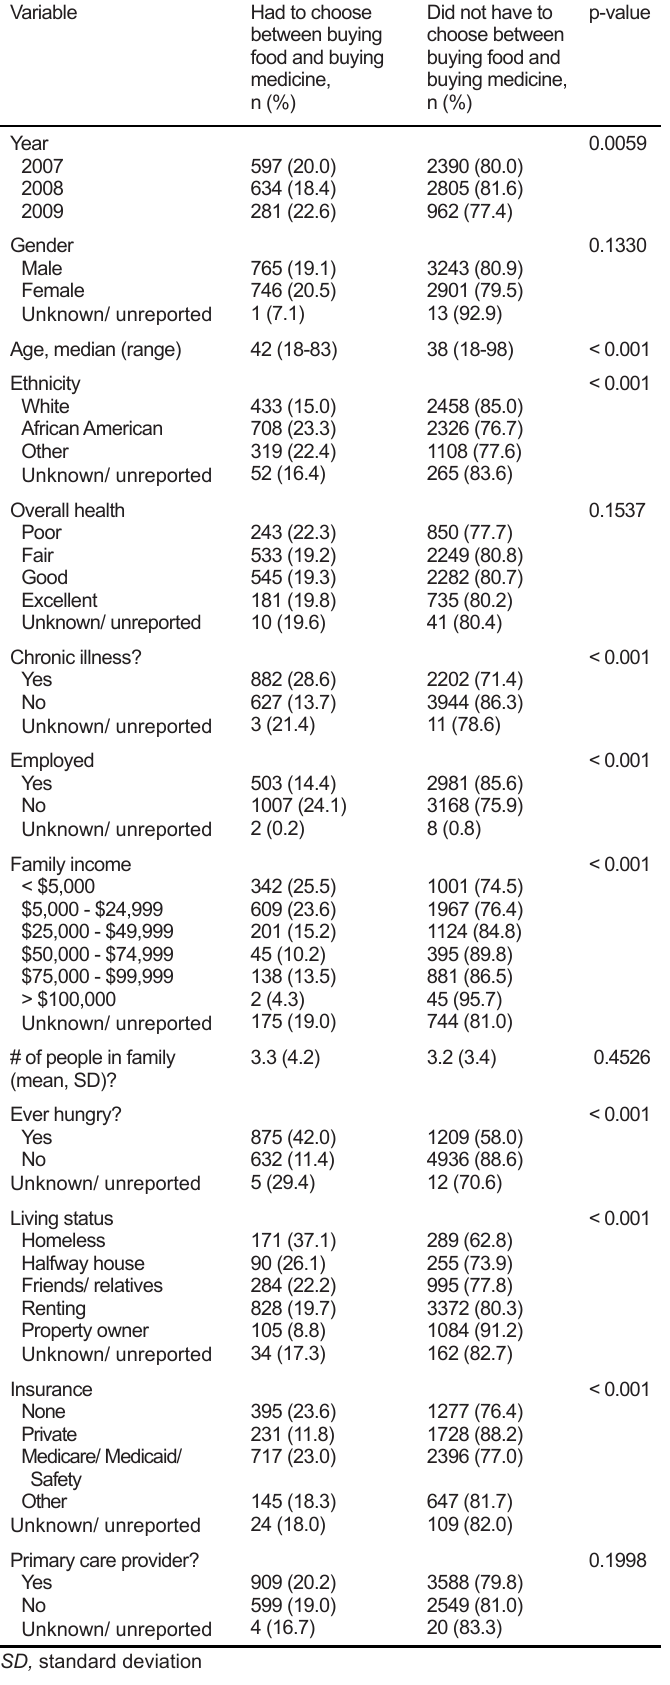
Table 5. Demographics by choosing between food and medicine